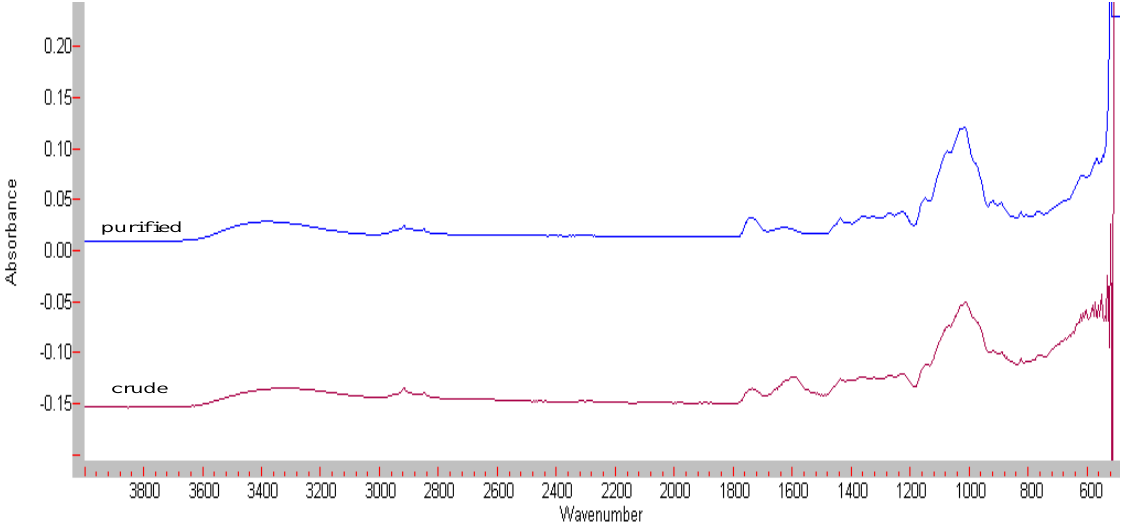
Figure 2. FT-IR spectra of crude and purified Yanang gum .